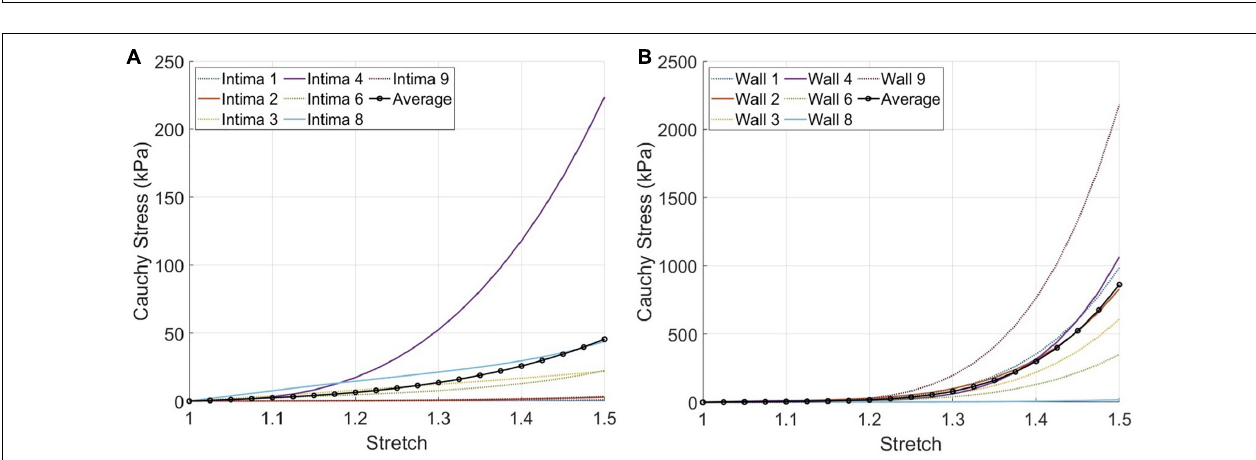
FIGURE 6 | The overall predicted material constants by the inverse finite element modeling (iFEM) predicted (A) and the Gaussian process (GP) inverted (B) methods for 10 cross-sections.